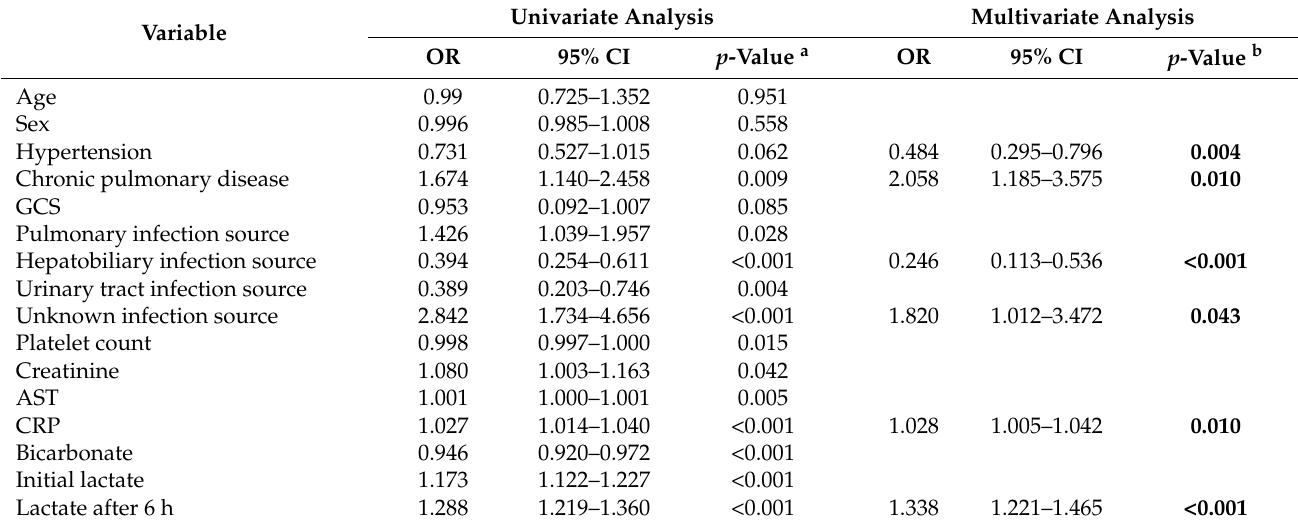
Table 4. Logistic regression analysis of risk factors associated with IHCA in septic shock